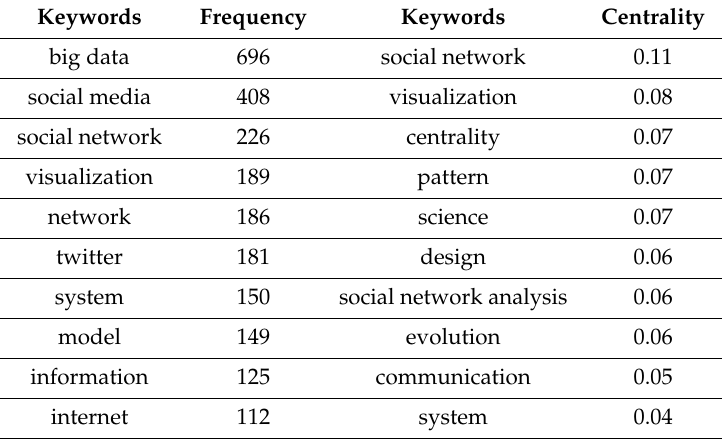
Table 6. Frequency and centrality of keywords in SMBD.